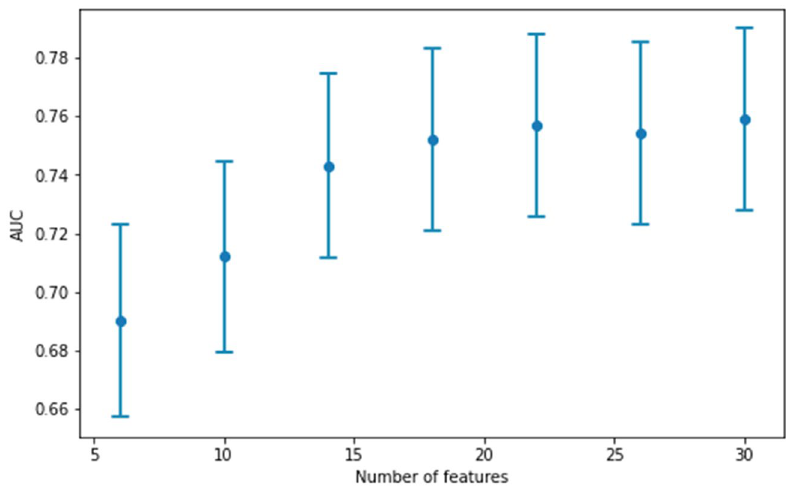
Figure 7. The models build on the k predictors with the highest SHAP